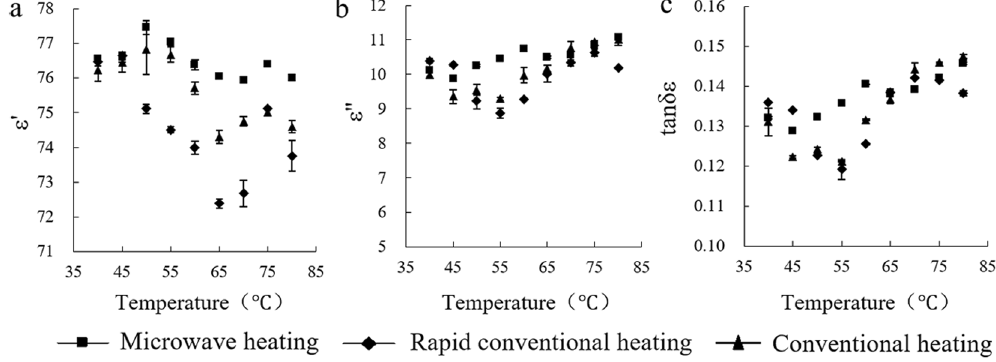
Figure 4. Curves of starch dielectric properties versus temperature at 2.45 GHz. ( a ) Permittivity ( b ) Dielectric loss ( c ) Dielectric loss